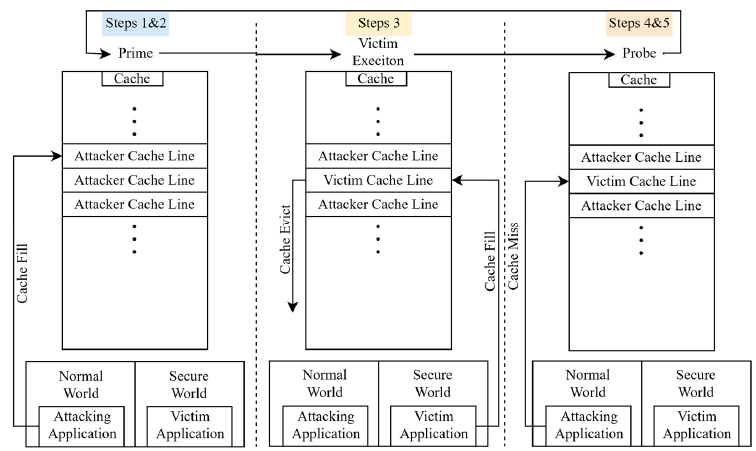
Figure 14. Prime + probe process of